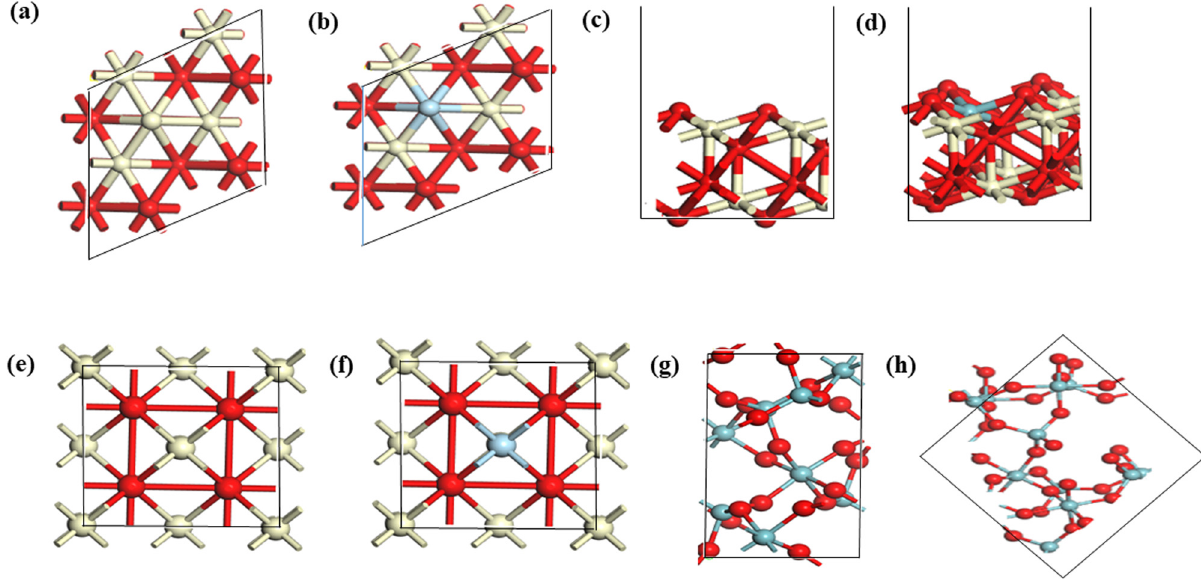
Figure 7: Structural geometries of ( a ) top view of un - doped, ( b ) top view of doped, ( c ) side view of un - doped, and ( d ) side view of doped CeO 2 surfaces ( slightly bent ) ; ( e ) un - doped bulk and ( f ) doped bulk CeO 2 ; ( g ) bulk Nb 2 O 5 ; and ( h ) Nb 2 O 5 surface. Red, grey, and light blue spheres refer to oxygen, cerium, and niobium atoms,